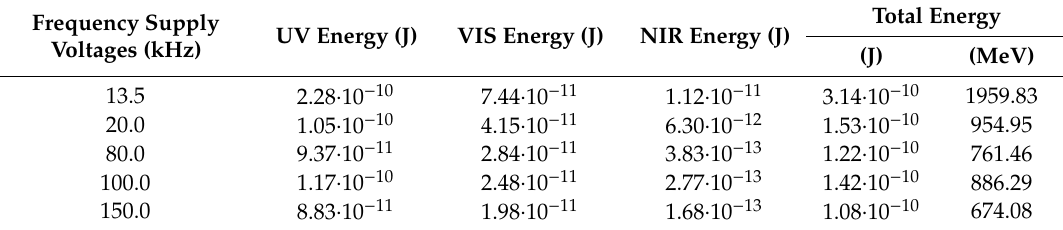
Table 2. Energy balance of optical radiation emitted by an electric arc.